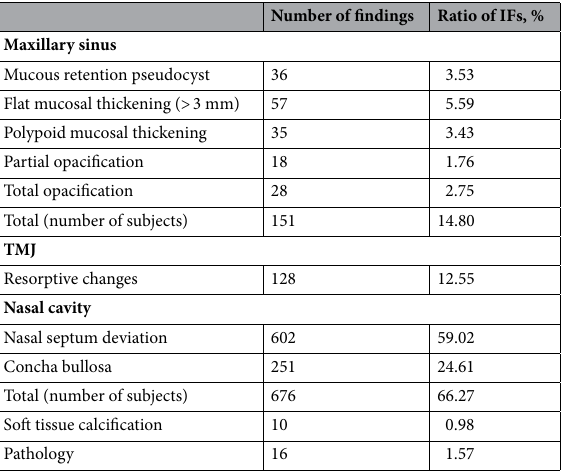
Table 3. Incidental findings on CBCT images.